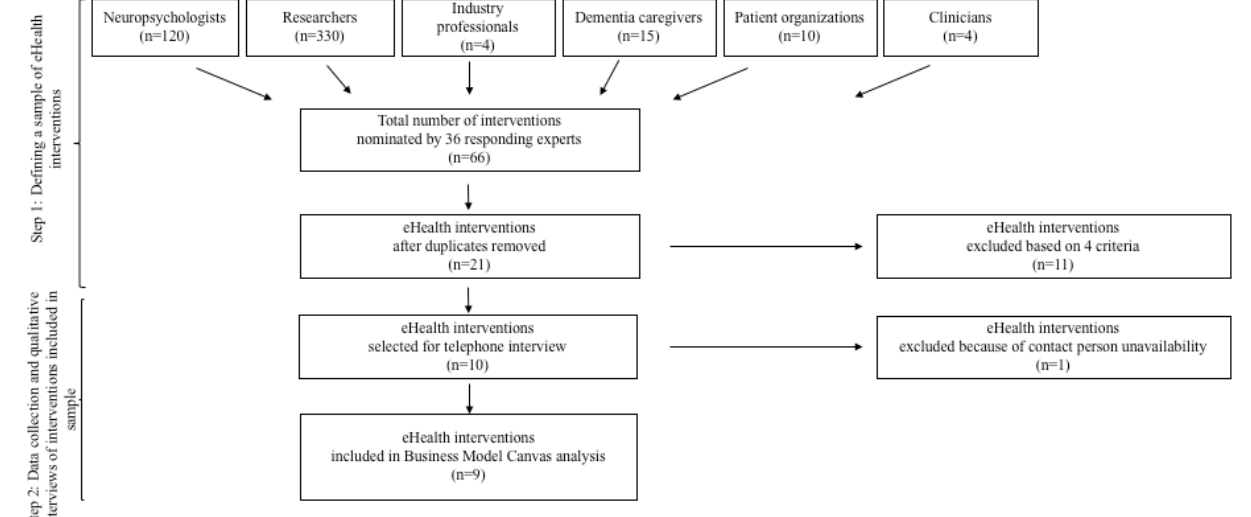
Figure 2. Flowchart of case study